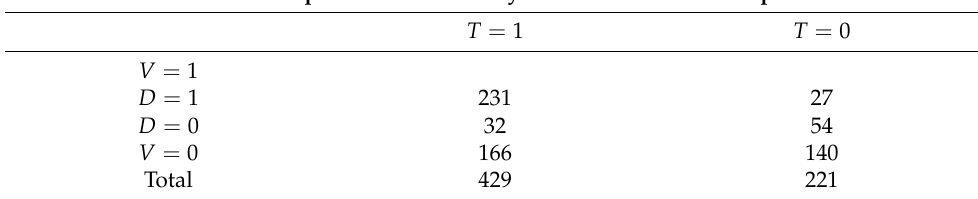
Table 7. Diagnosis of liver